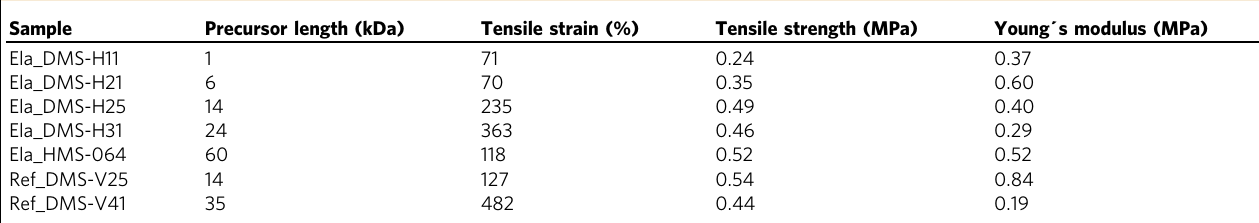
Table 1 Silicone elastomers prepared from telechelic/multi Si – H functional PDMS in presence of a platinum-divinyl tetramethyldisiloxane complex.